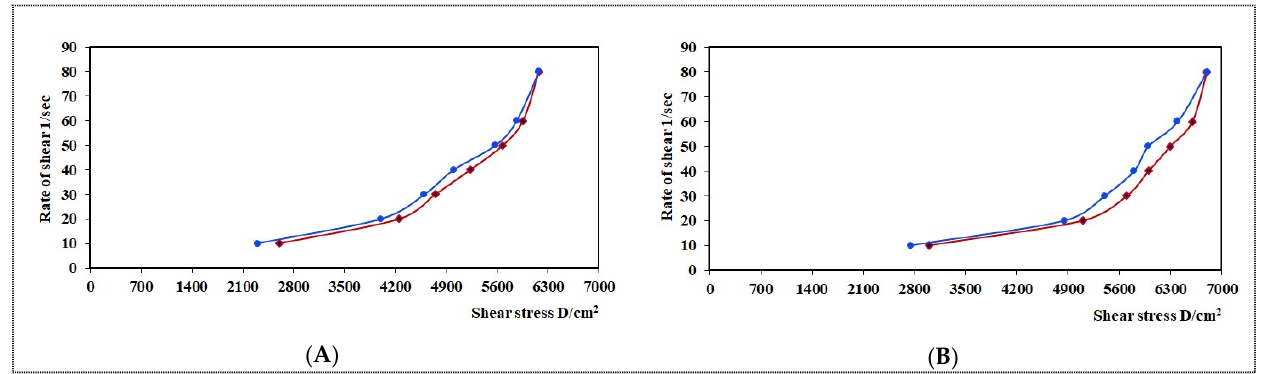
Figure 4. Rheograms of ( A ) plain hydroxypropyl cellulose (HPC) hydrogel (G4) and ( B ) HPC hydrogel loaded with optimized CO-NE